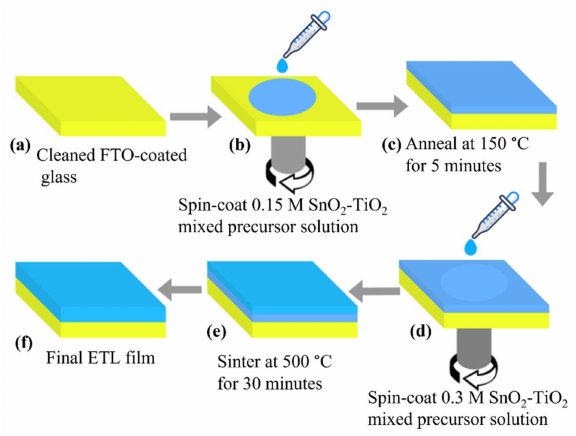
Figure 1. ( a – f ): Schematics of the ETL preparation